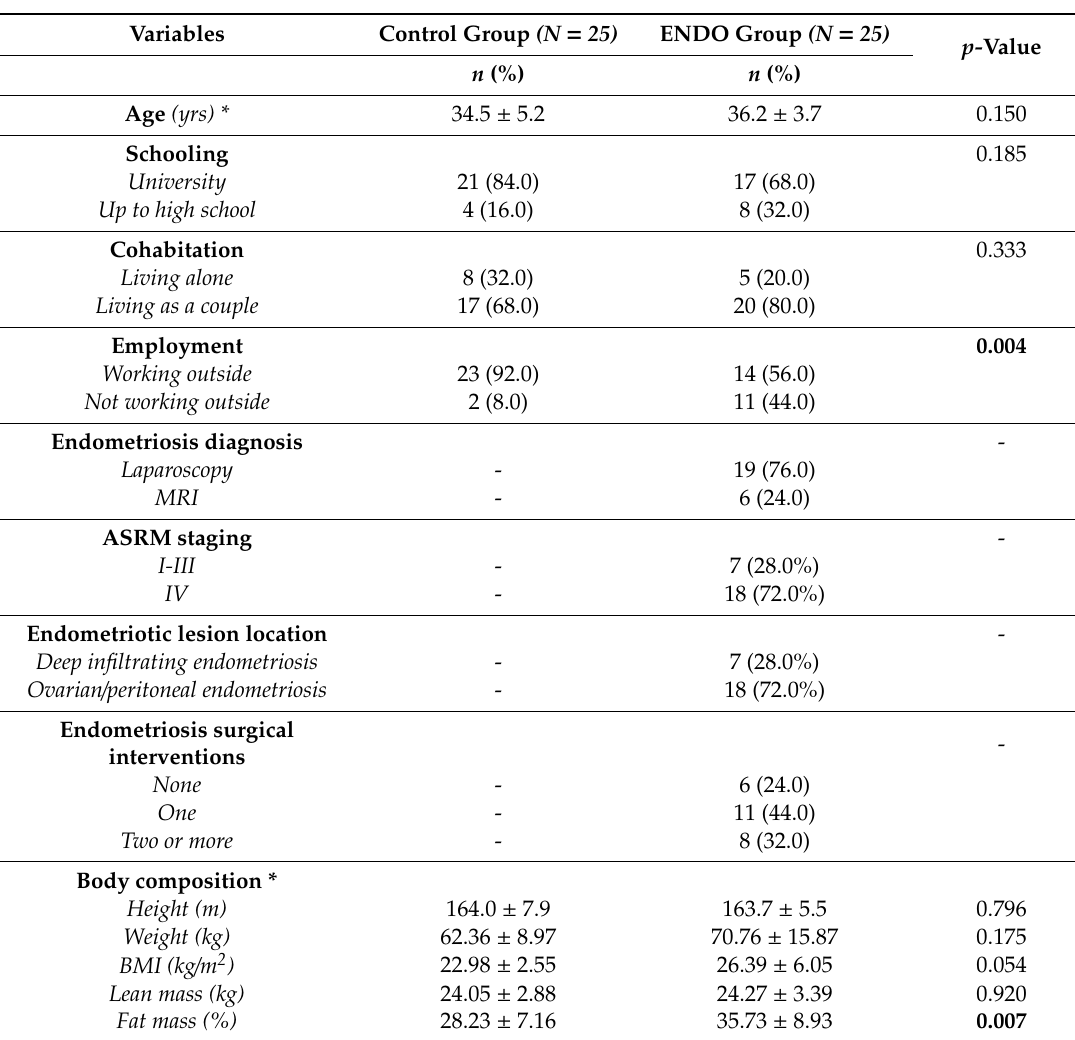
Table 1. Characteristics of the study population ( N =